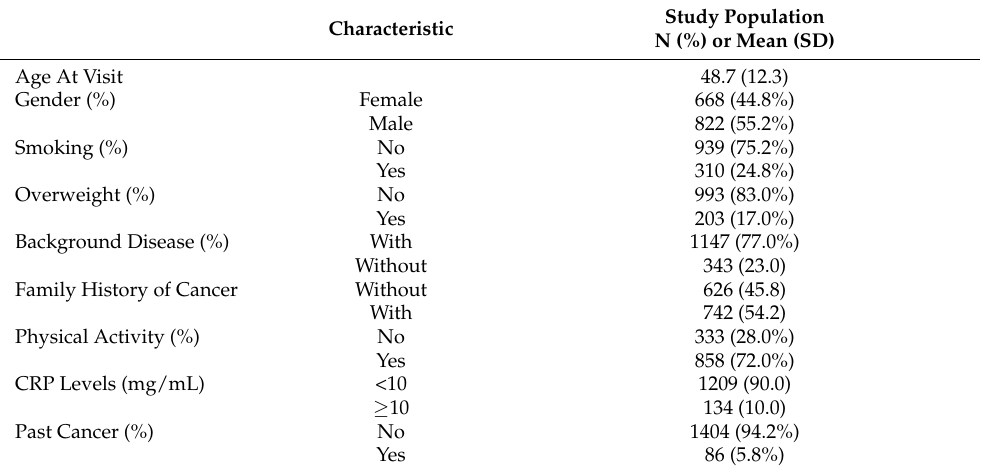
Table 1. Demographic and population characteristics of the participants (N =